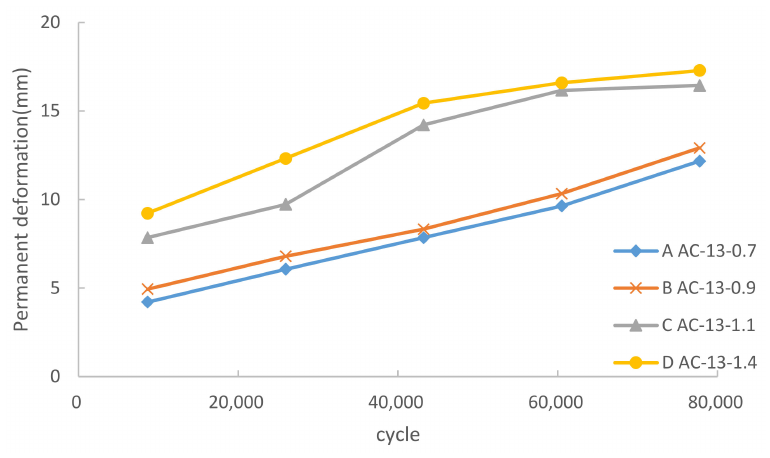
Figure 4. Heavy load e ff ect on permanent